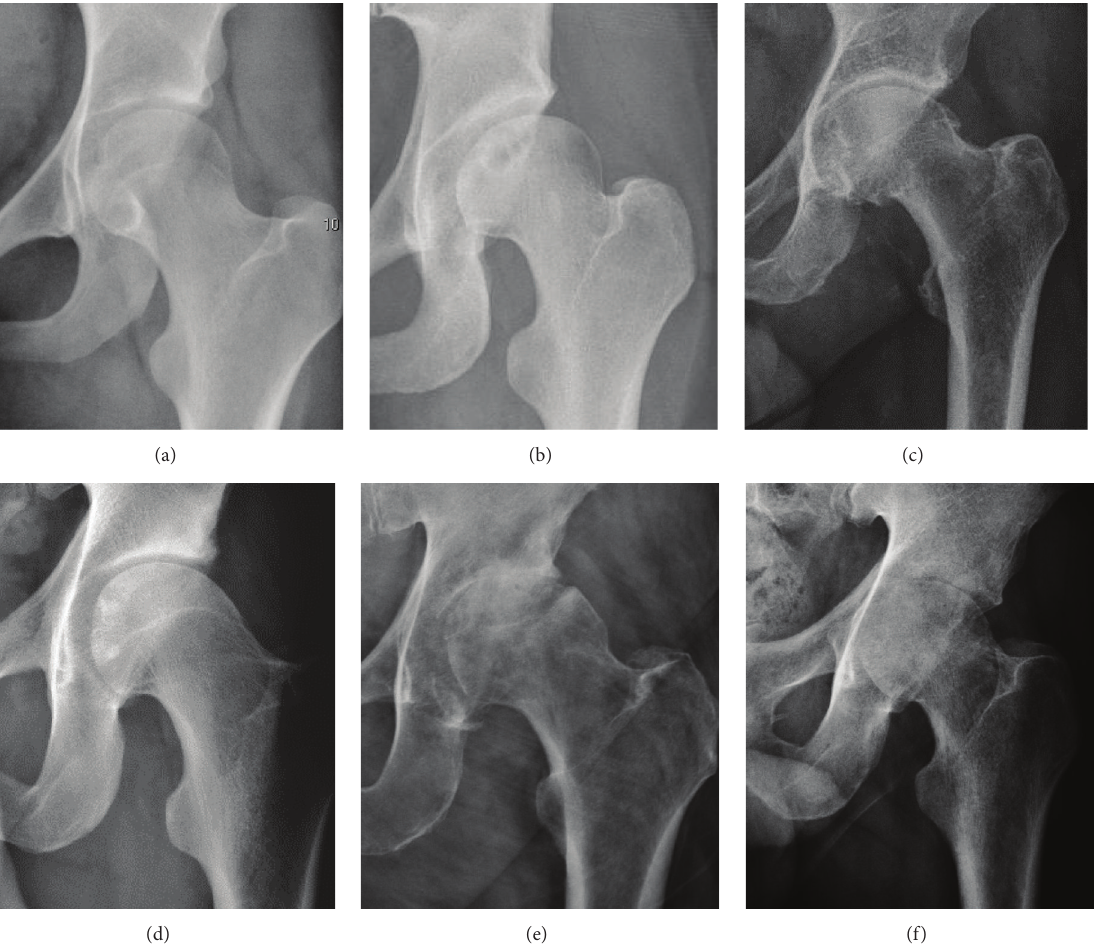
Figure 1: Radiography in normal hip (a), hip dysplasia (b), pincer impingement type (c), and cam (d). Hip in osteoarthritis (e) and septic arthritis